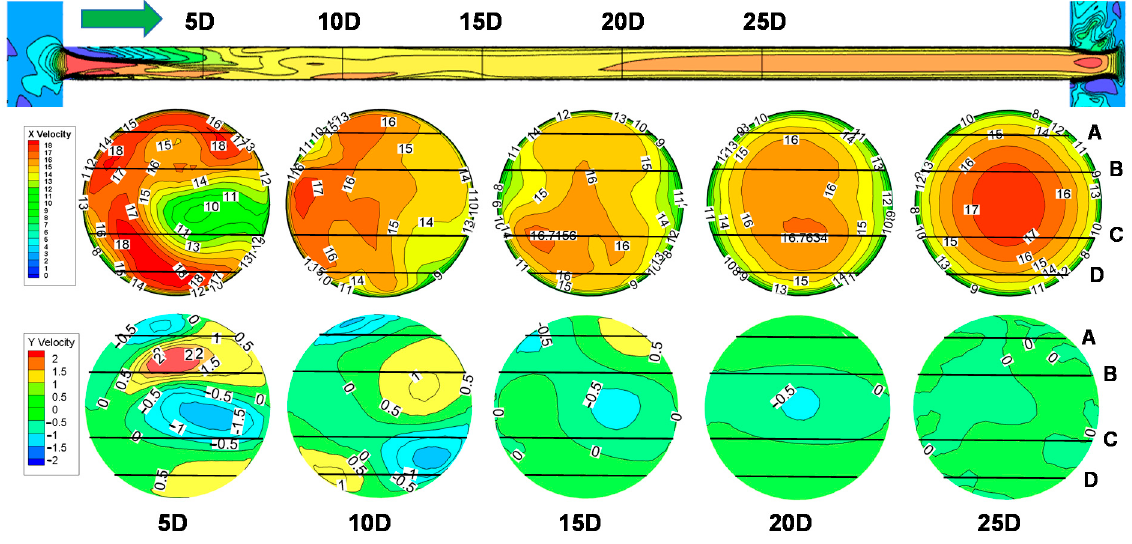
Figure 14. Contours of velocity profiles on the different cross-sections downstream of the header without FC.